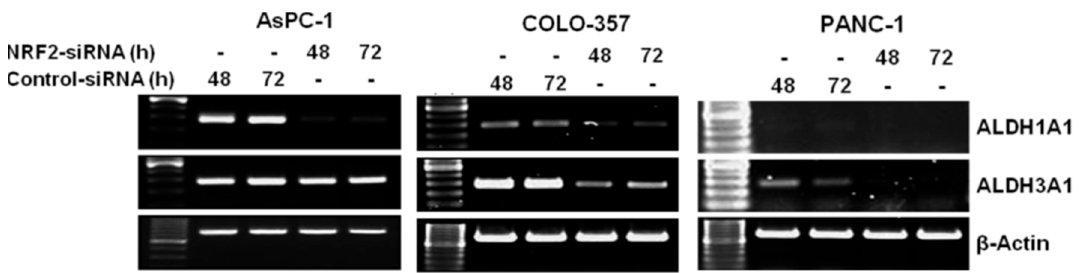
Figure 3. NRF2 knockdown inhibits the mRNA expression of ALDH1A1 and ALDH3A1. AsPC-1, COLO-357 and PANC-1 cells transfected with NRF2-siRNA or control-siRNA for 48 h or 72 h were subjected to RT-PCR analysis using primers specific for ALDH1A1, ALDH3A1 and β -Actin.